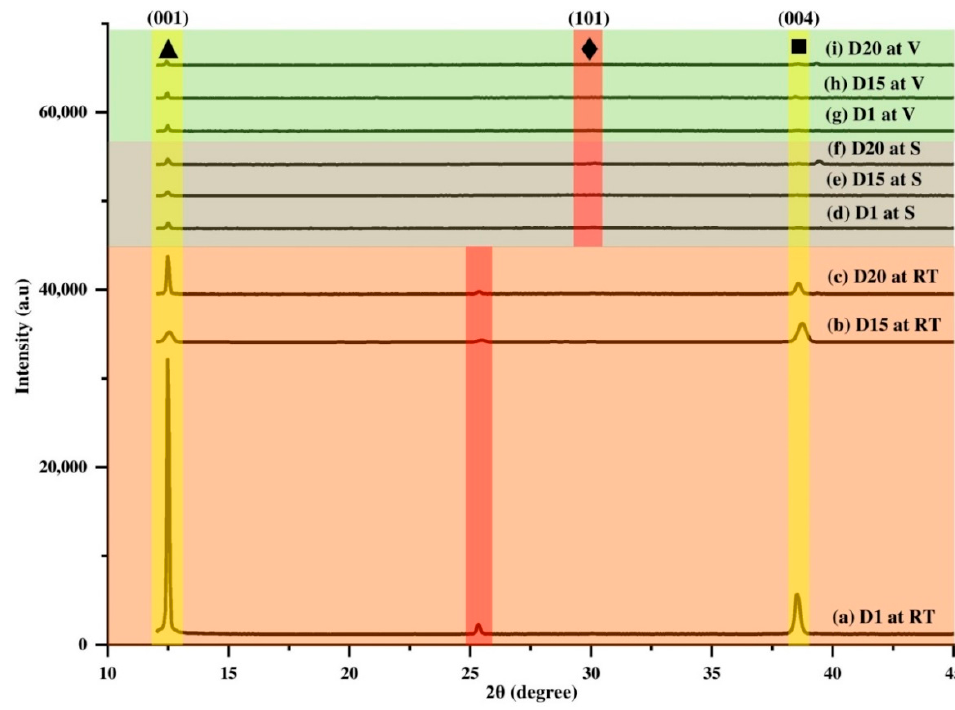
Figure 8. XRD spectrum of I ‐ AMP shows ▲ , ♦ and ■ marked for PbI 2 (001), perovskite (101) and TiO 2 (004), respectively. TiO 2 (004),